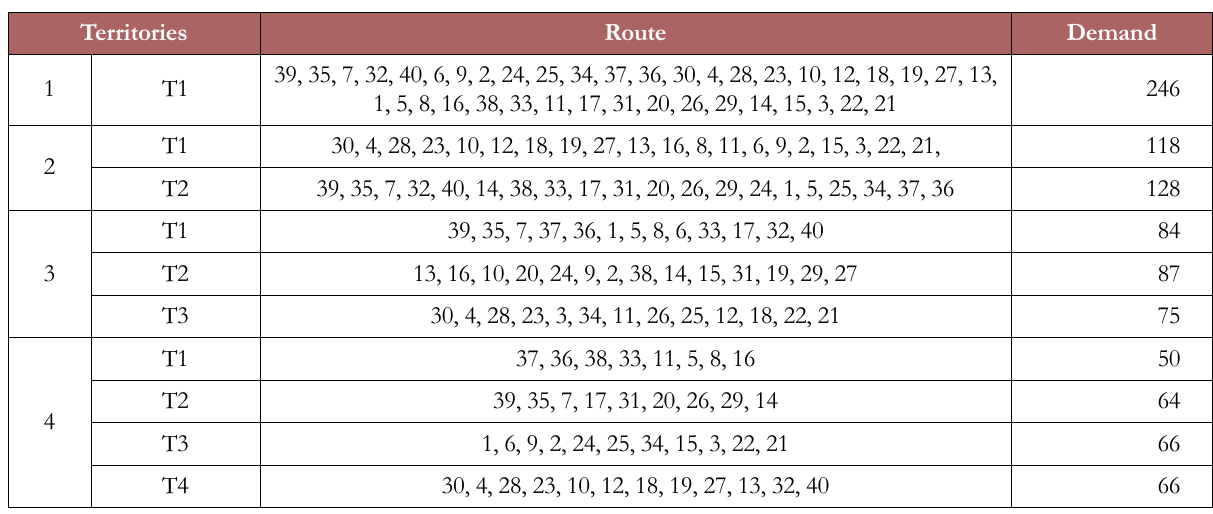
Table 5. Distribution routes and demand in each